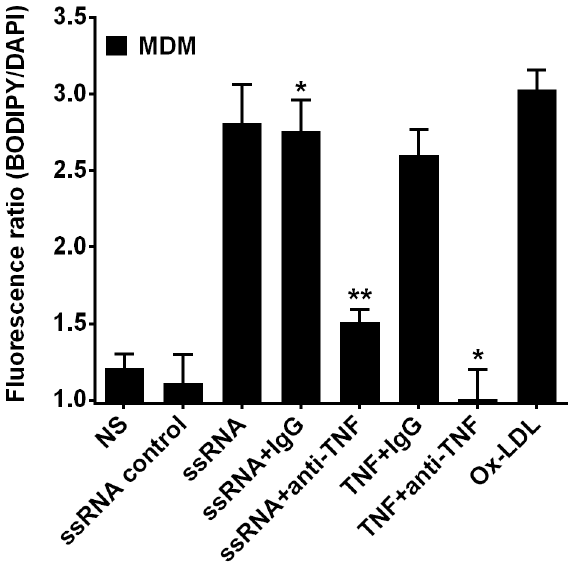
Figure 3. Induction of foam cell formation by HIV-derived ssRNA is dependent on TNF a . MDMs were pre-treated with anti- TNF a for 1 h followed by ssRNA incubation for 24 h and stained with either Oil Red O staining ( A ) or BODIPY staining ( B ). Data shown is a representative experiment with similar results from four different healthy uninfected subjects. *p , 0.05 compared to ssRNA control, TNF + IgG, **p , 0.01 compared to ssRNA + IgG.